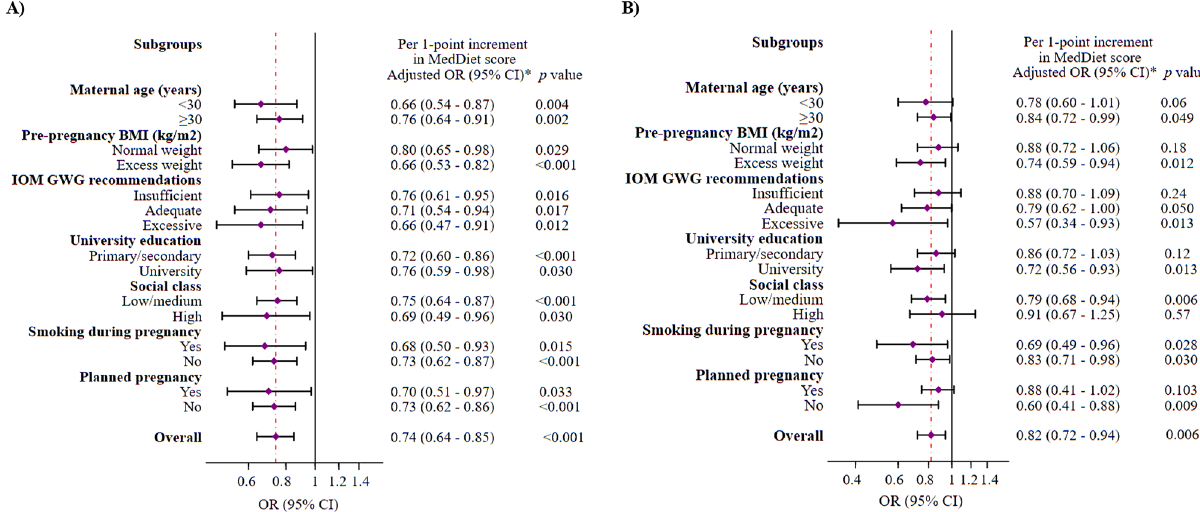
Figure 1. Multivariable-adjusted ORs (95% CIs) of SAG (< P 10 ) infant at birth in weight ( A ) and head circumference ( B ) associated with a 1-point increase in the maternal rMedDiet score for selected subgroups. *Models were adjusted for age (< 25, 25–29, ≥ 30), energy intake (Kcal/day), BMI (kg/m 2 ), IOM GWG recommendations (insufficient, adequate, excessive), educational level (primary or lower, secondary, university) smoking (yes, no), social class (low, middle, high), type of delivery (normal vaginal, caesarean) primiparous (yes, no), and planned pregnancy (yes, no), except for the variables used as subgroup variables in each case. The diamonds represent OR and the whisker plots represent 95% CIs. BMI body mass index, GWG gestational weight gain, rMedDiet Mediterranean